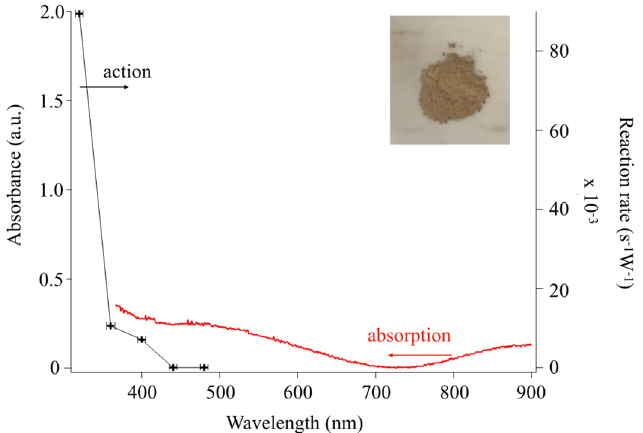
Figure 15. Action and absorption spectrum of Cu-TiO 2 prepared with 10.0 mM of Cu nitrate. Ther- mal treatment under nitrogen for 1 h was performed after synthesis. Inset shows photograph of doped sample.